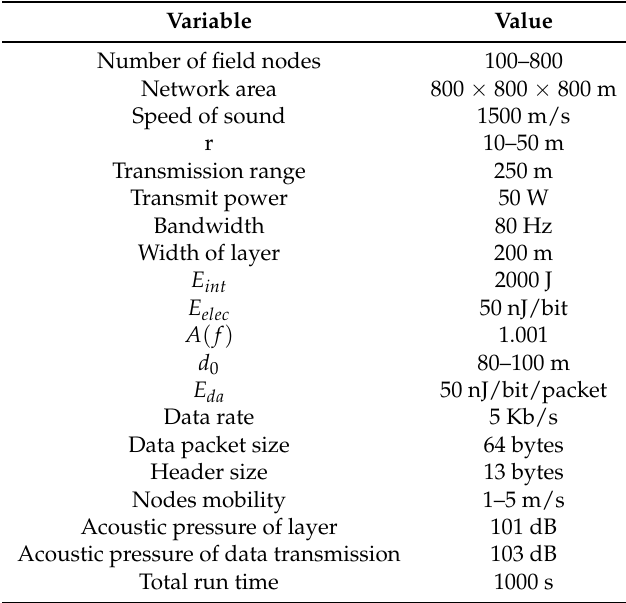
Table 1. Parameter values used for the